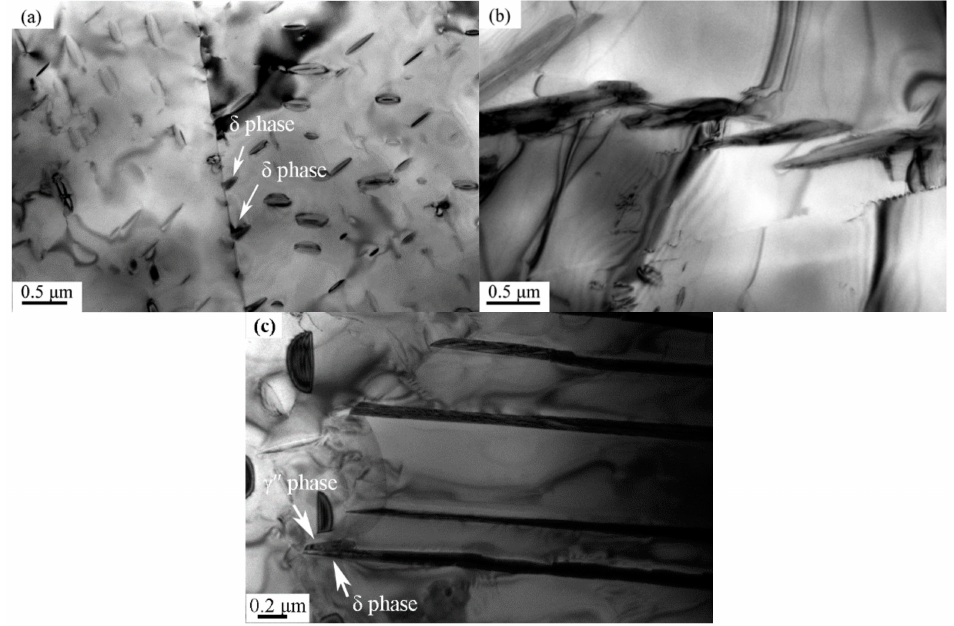
Figure 2. Transmission electronic microscopy (TEM) images of ( a ) δ phase precipitated at grain boundaries; ( b ) paralleled δ phase close to the grain boundaries; ( c ) the encounter between δ phase and γ ” phase in GH4169